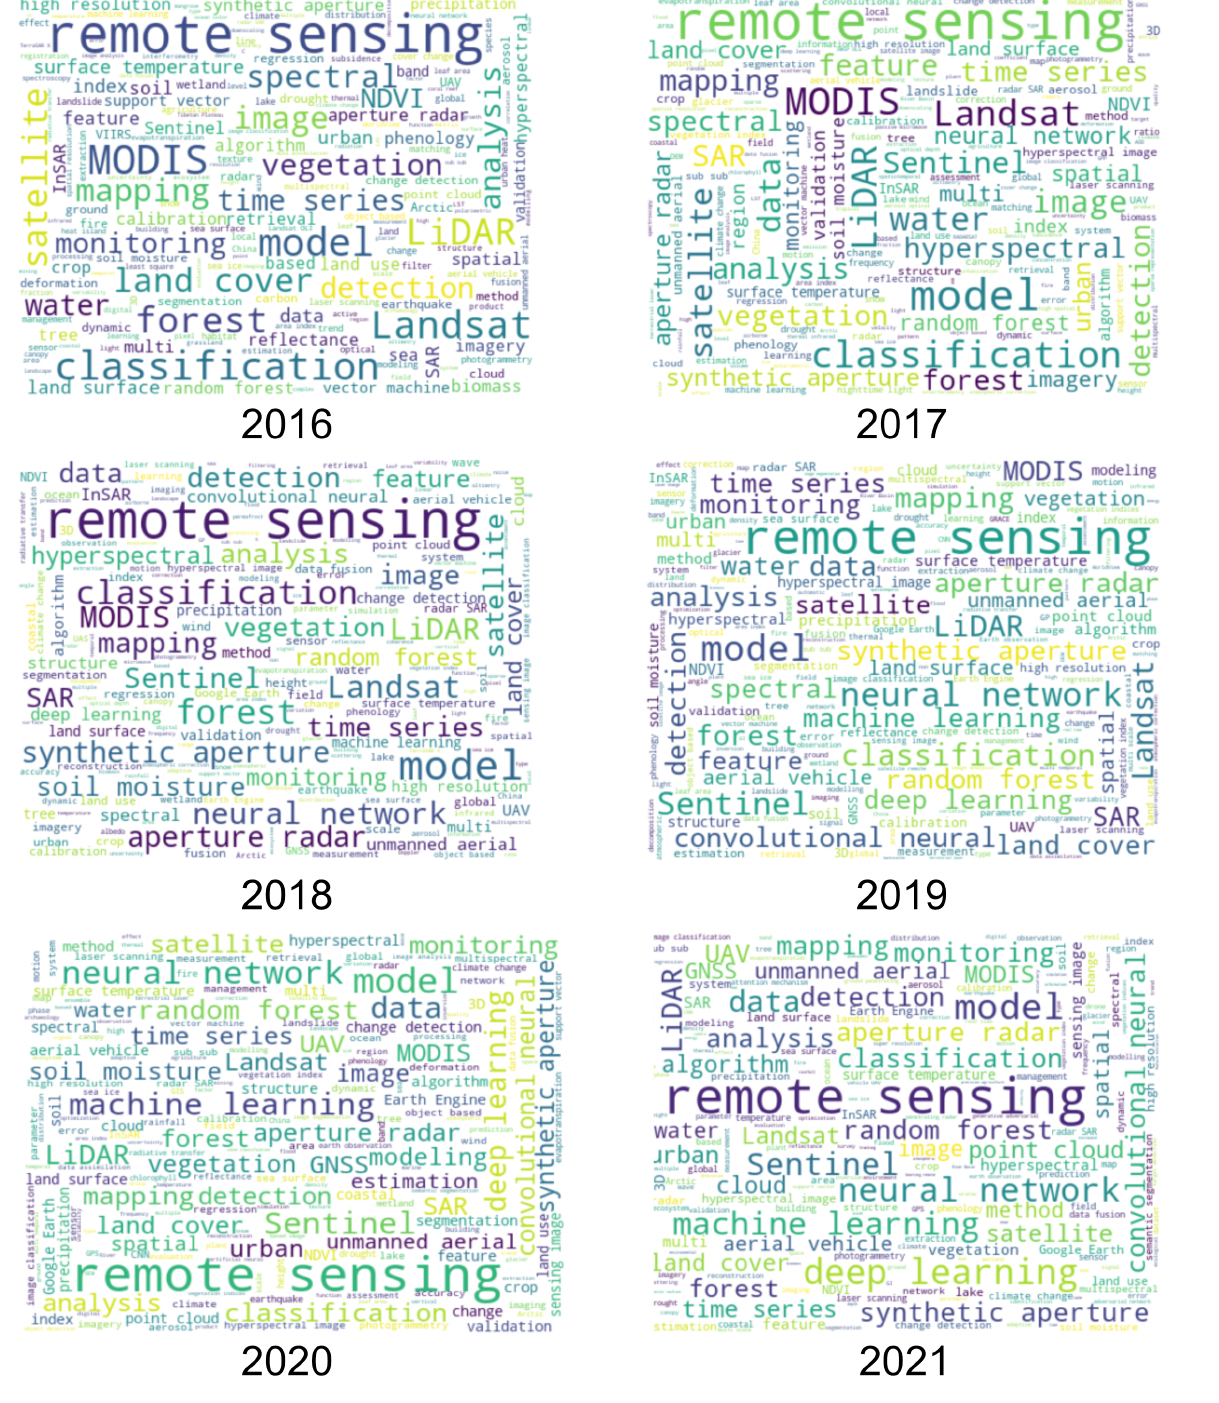
Figure 3. Word clouds derived from keywords of articles published in Remote Sensing be- tween 2016 and